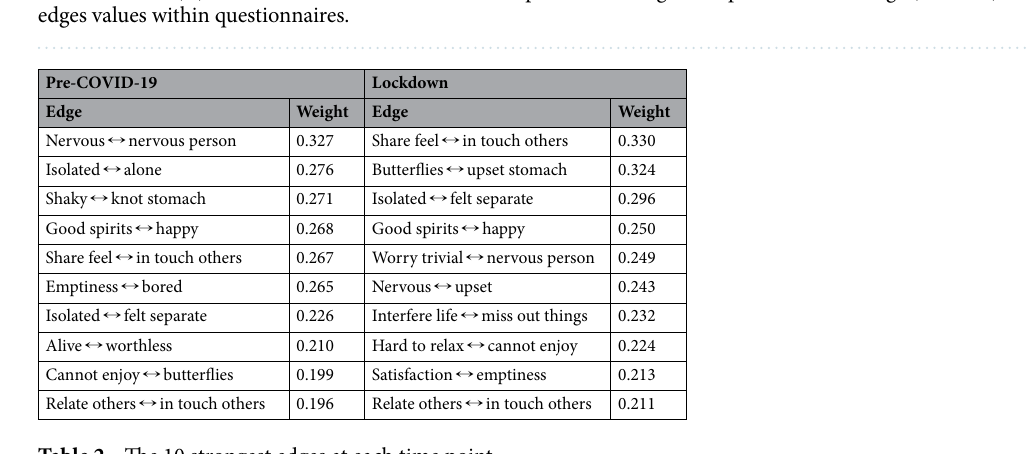
Table 2. The 10 strongest edges at each time